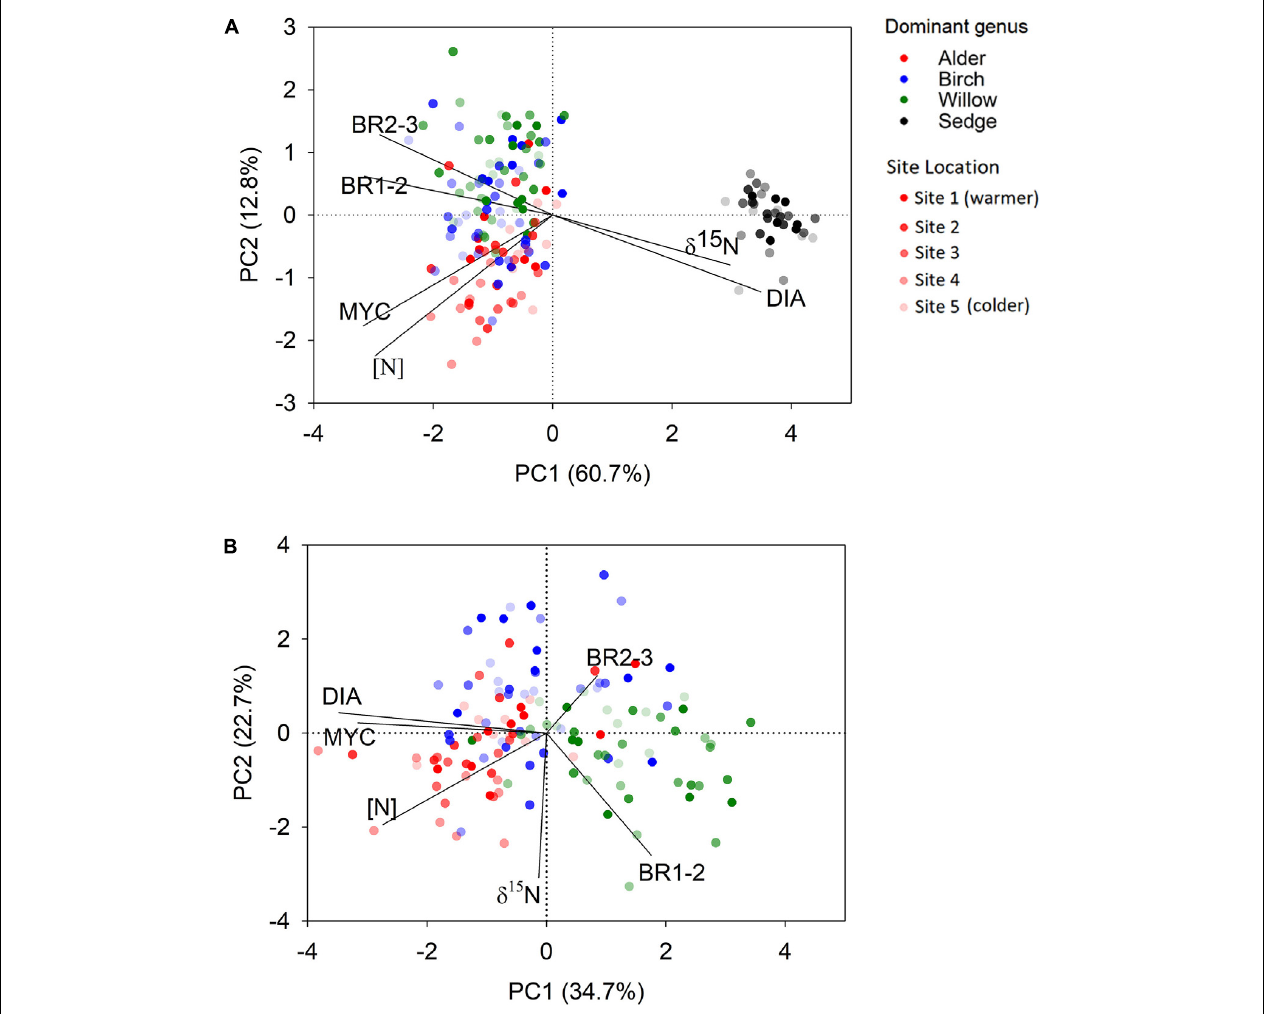
FIGURE 2 | Score plot of shrubs and tussock sedges in the principal component analysis for all root samples (A) and shrub samples only (B) . Samples from higher latitude sites are indicated with greater transparency. DIA = root diameter, [N] = root nitrogen concentration, MYC = ectomycorrhizal colonization, BR1-2 = number of 1st order roots per each 2nd order root, BR2-3 = number of 2nd order roots per each 3rd order root, and δ 15 N = stable isotope ratios of nitrogen in roots. Statistical summary of the principal component analysis is shown in Supplementary Tables 3 , 4